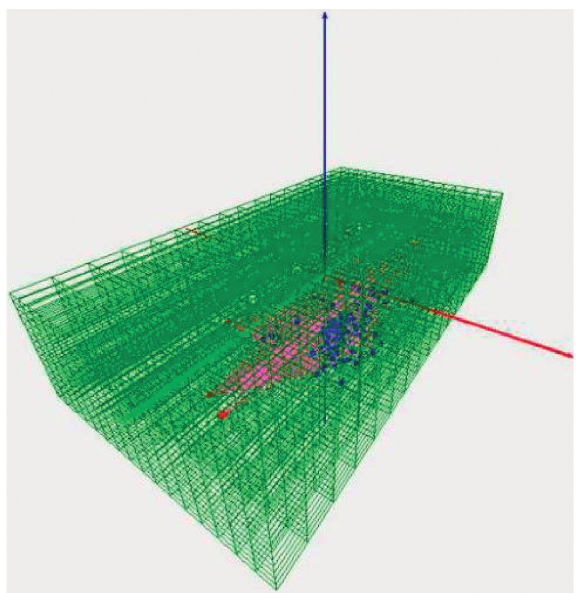
Figure 9: Model diagram of passive velocity tomography of